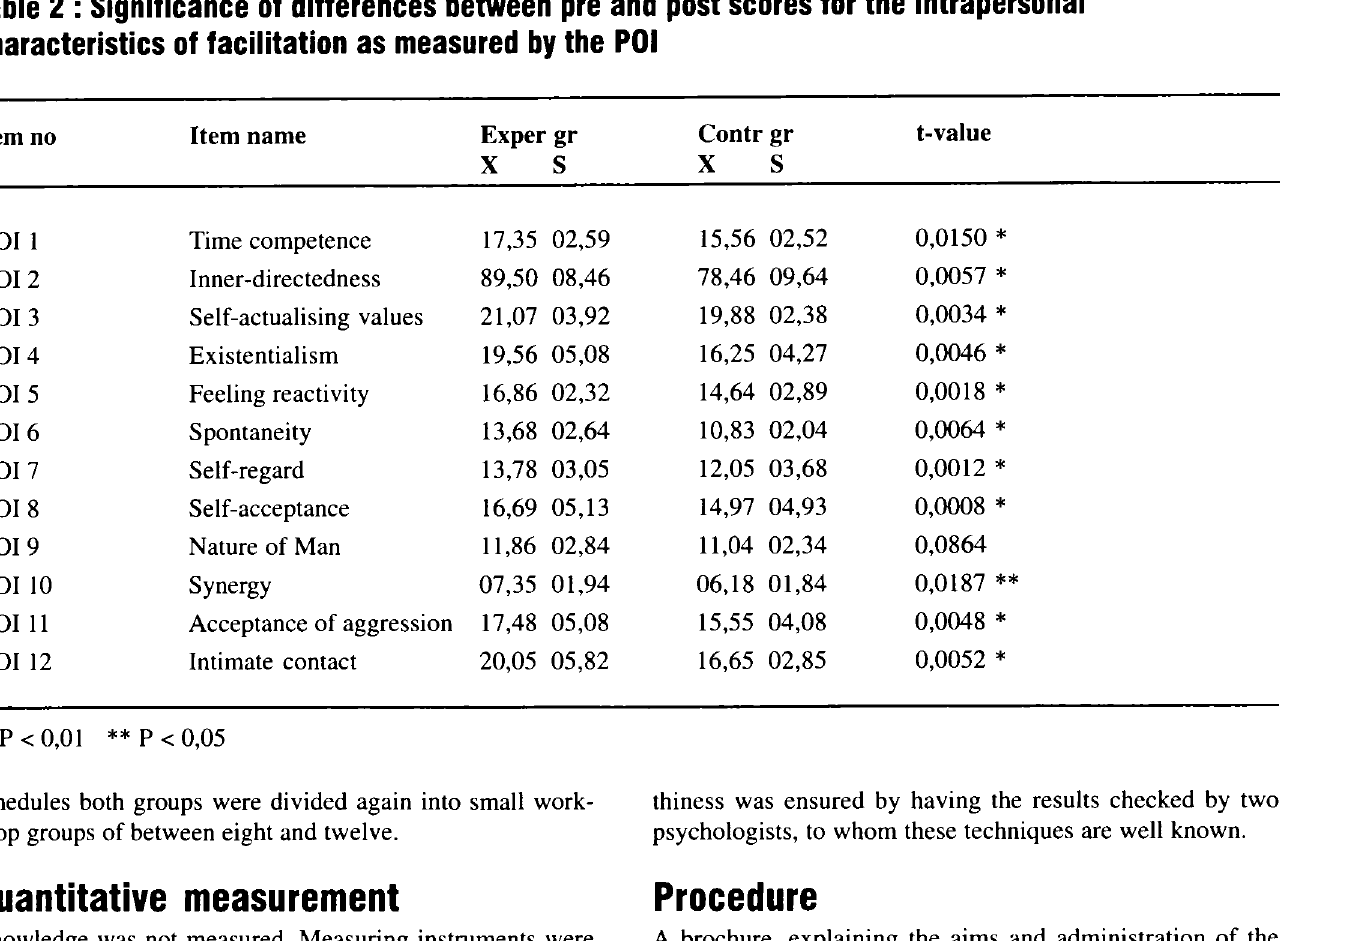
Table 2 : Significance of differences between pre and post scores for the intrapersonal characteristics of facilitation as measured by the